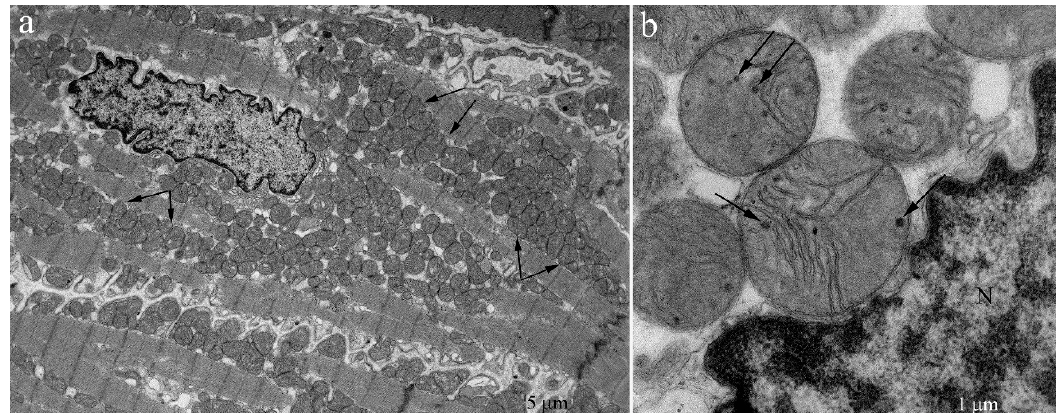
Figure 1. Electron microscopic images of the ultrastructure of a left ventricular cardiomyocyte from a 6-month-old naked mole rat: ( a ) General view photo at low magnification. Long rows of mitochondria along myofibrils are visible. Arrows show mitochondria located within a sarcomere. ( b ) Ultrastructure of a single mitochondrion at higher magnification. Arrows show the electron-dense granules in the matrix. N—cardiomyocyte nucleus.